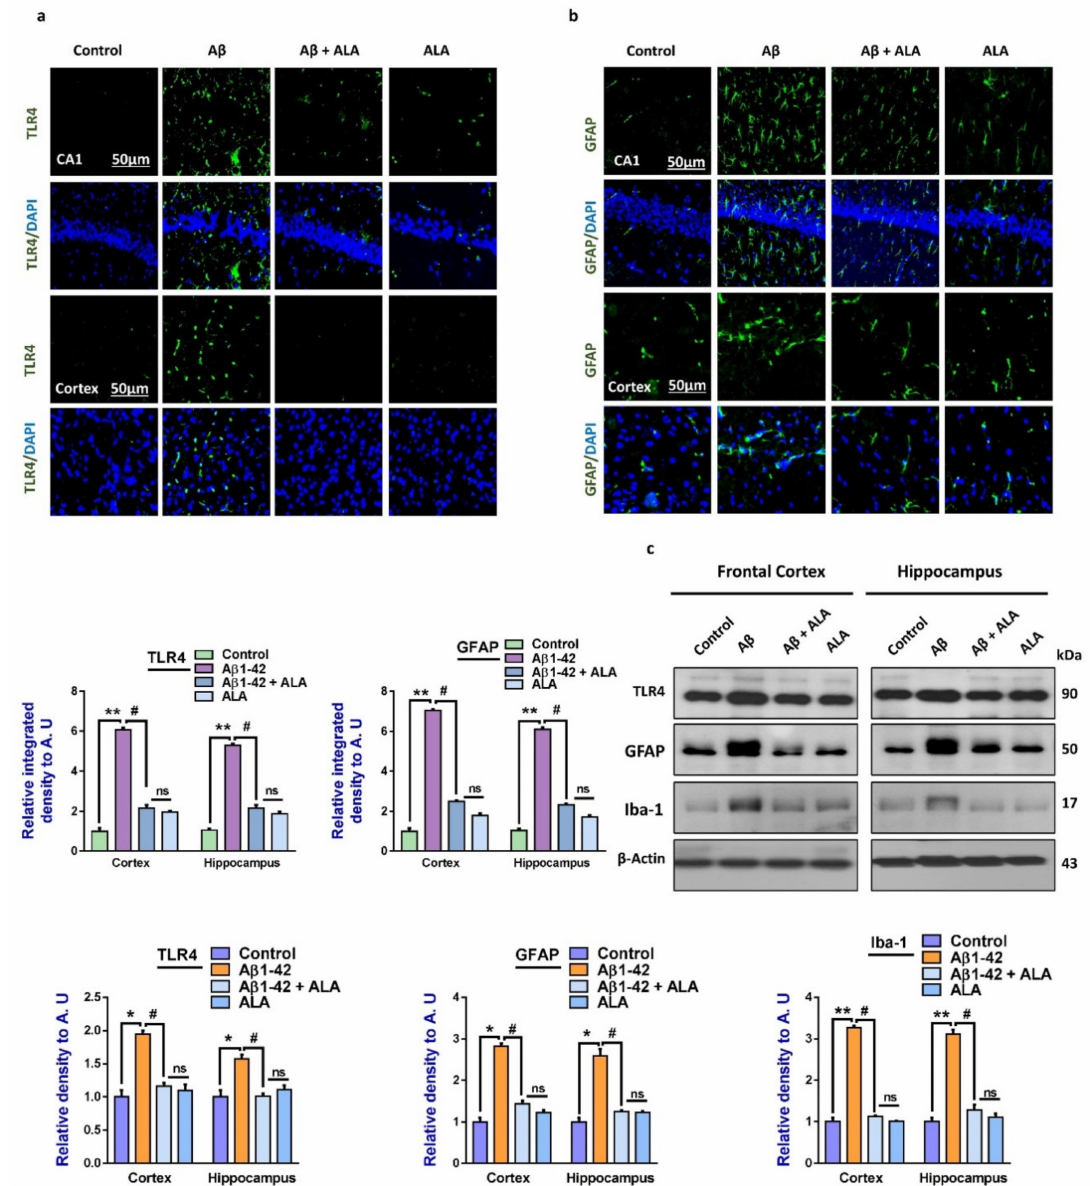
Figure 1. E ff ects of alpha linoleic acid against amyloid-beta (A β )-induced activated Toll-like receptor 4 (TLR4), glial fibrillary acidic protein (GFAP), and ionized calcium adaptor molecule 1 (Iba-1) in mouse brains. ( a ) and ( b ): Immunofluorescence results of TLR4 and GFAP in the frontal cortices and hippocampi (CA1) of the treated mice groups, with respective bar graphs. Magnification: 30 × ; scale bar: 30 and 50 µ m. ( c ) Western blot results of Toll-like receptor 4 (TLR4), glial fibrillary acidic proteins (GFAP), and ionized calcium-binding adaptor molecule 1 (Iba-1), with respective bar graphs. * Significantly di ff erent from the A β -treated group; # significantly di ff erent from the A β + ALA-cotreated group. Significance = * p < 0.05; * * p < 0.01; # p < 0.05; and ## p < 0.01. A β : amyloid beta; ALA: alpha linoleic acid; DAPI: 4 (cid:48) ,6-diamidino-2-phenylindole; ns = non